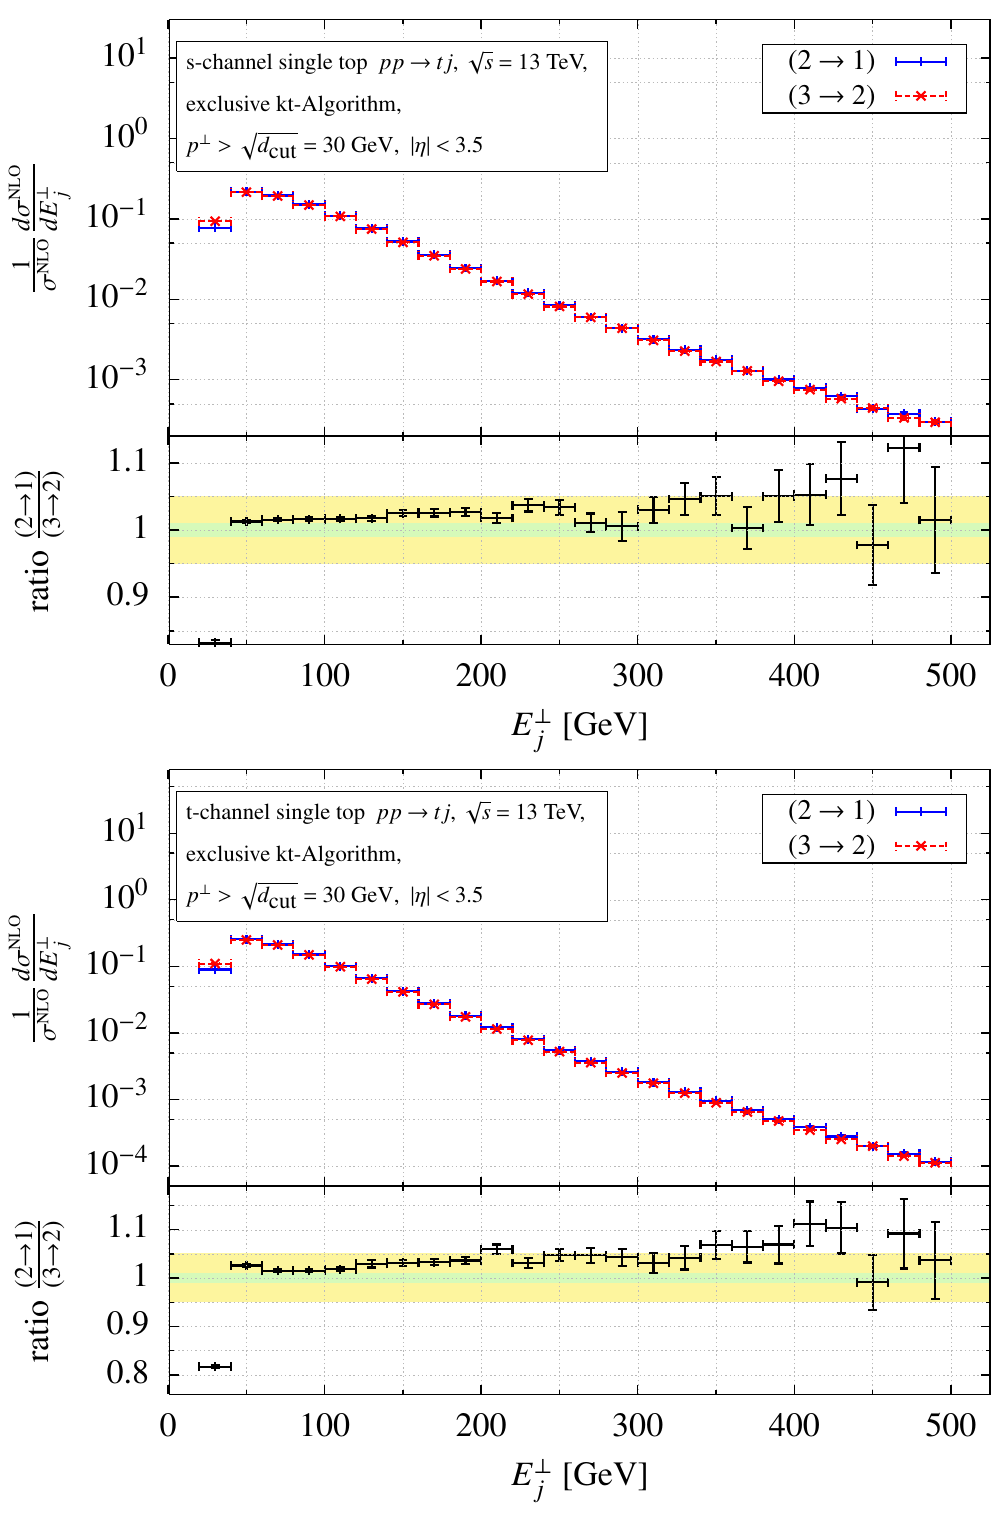
Figure 22 . Transverse energy distributions of the light jet from s - and t -channel single top-quark production at NLO with 3 ! 2 (red, dashed) and 2 ! 1 (blue, solid) jet clusterings.